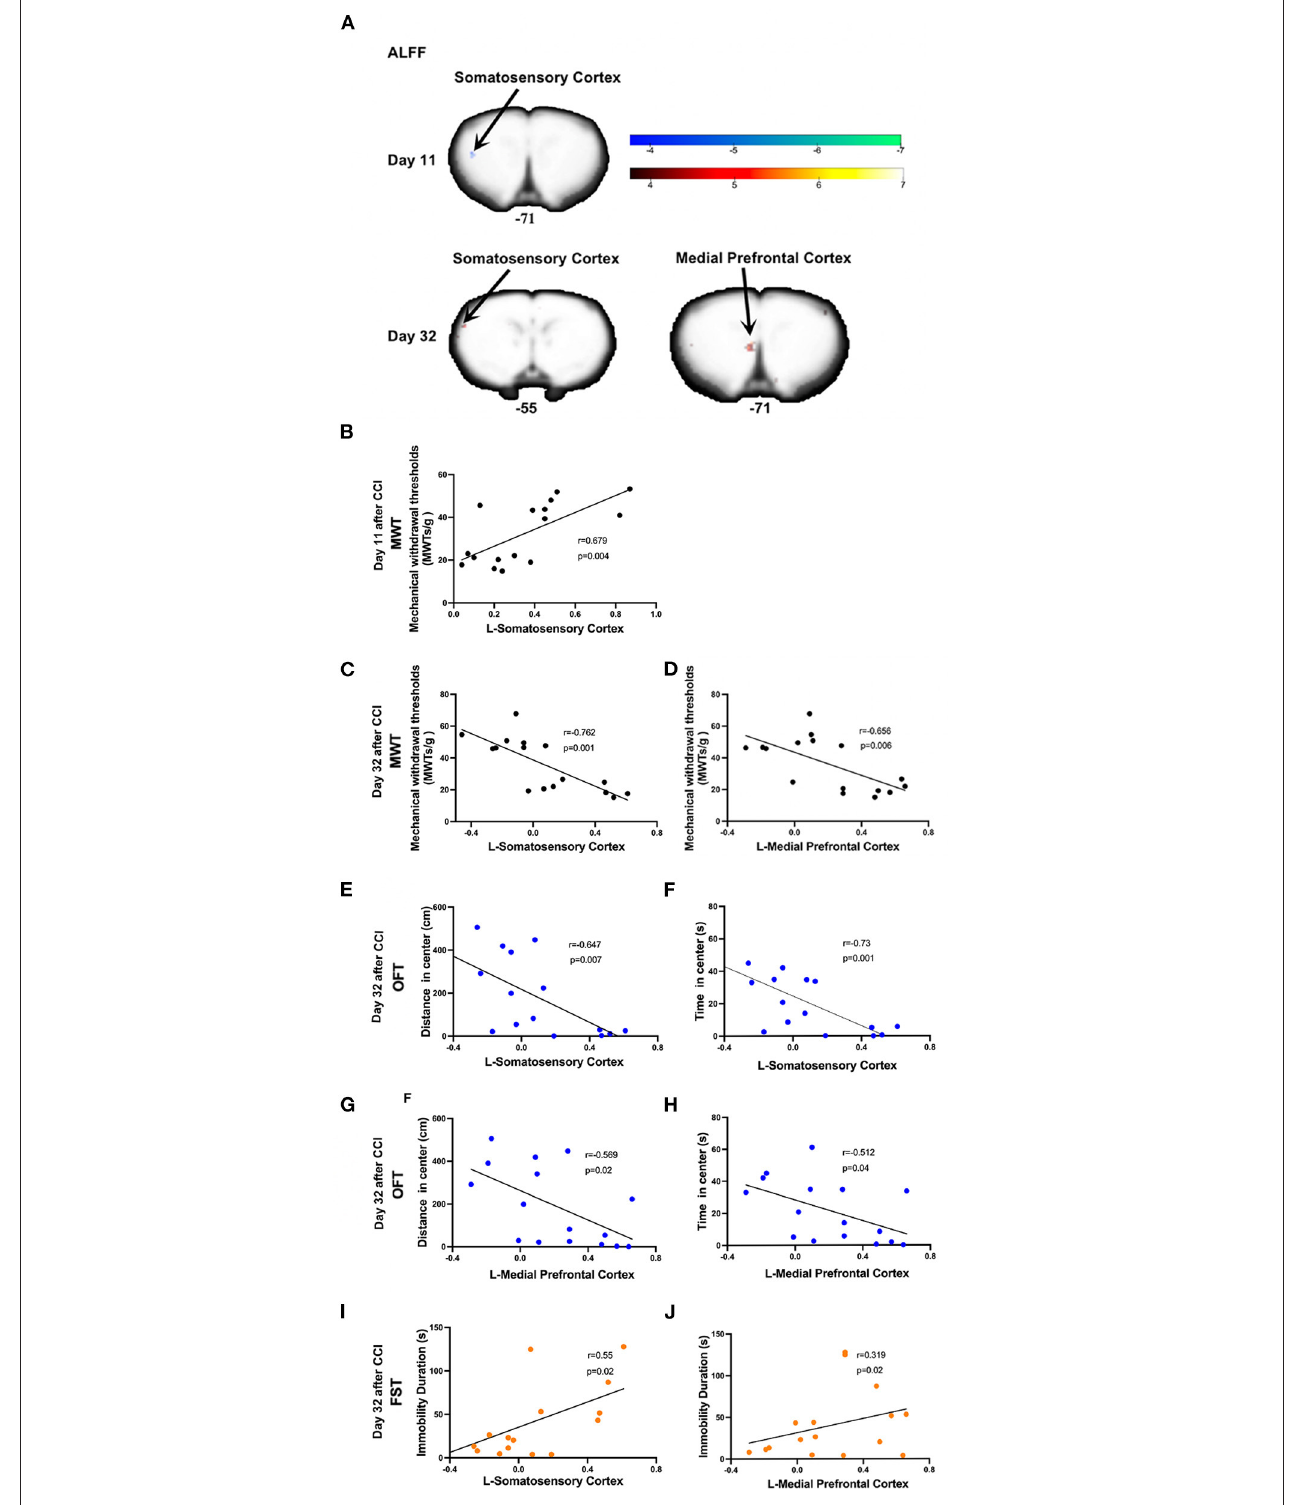
FIGURE 4 | Significant alternations in ALFF induced by CCI and correlations between ALFF values and the mechanical withdrawal thresholds (MWT) values, open field test (OFT) data, and forced swimming test (FST) data. (A) CCI group rats were found to exhibit significantly lower ALFF values in the left somatosensory cortex on